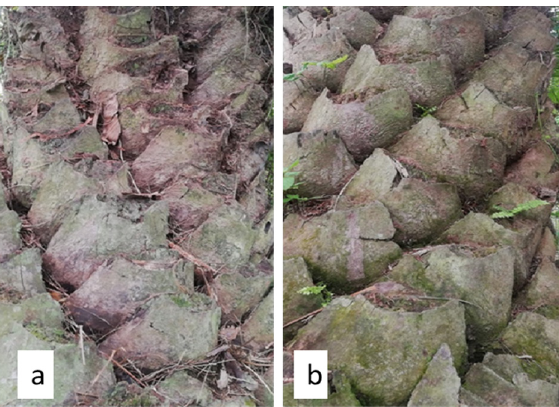
Figure 1. Spiral directions of left- and right-handed phyllotaxis palm trunks: ( a ) left-handed palm and ( b ) right-handed palm trunk.